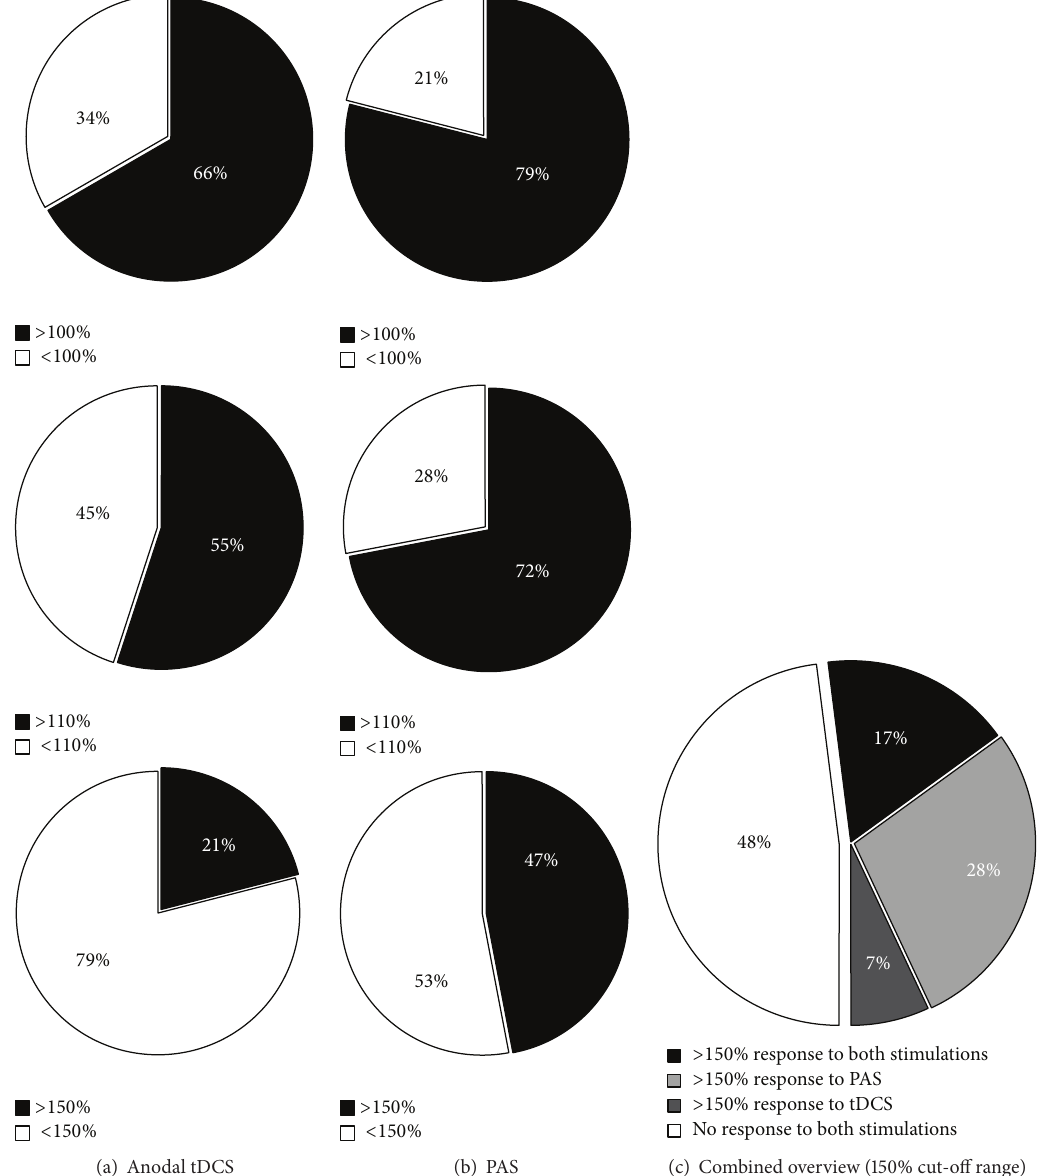
Figure 3: Individual response patterns of all subjects for (a) anodal tDCS and (b) PAS separated according to the defined cut-off ranges of > 100%, > 110%, and > 150% relative to baseline MEP values (set as 100%). Responders ( 𝑅 ) are depicted with grey coloured fields and nonresponders (NR) with white fields. (c) Grouped presentation of responders to both stimulation types (17%, dark grey), to PAS only (28%, light grey), or to anodal tDCS only (7%, intermediate grey) and nonresponders (48%, white) for the > 150% cut-off range relative to baseline MEP values (set as